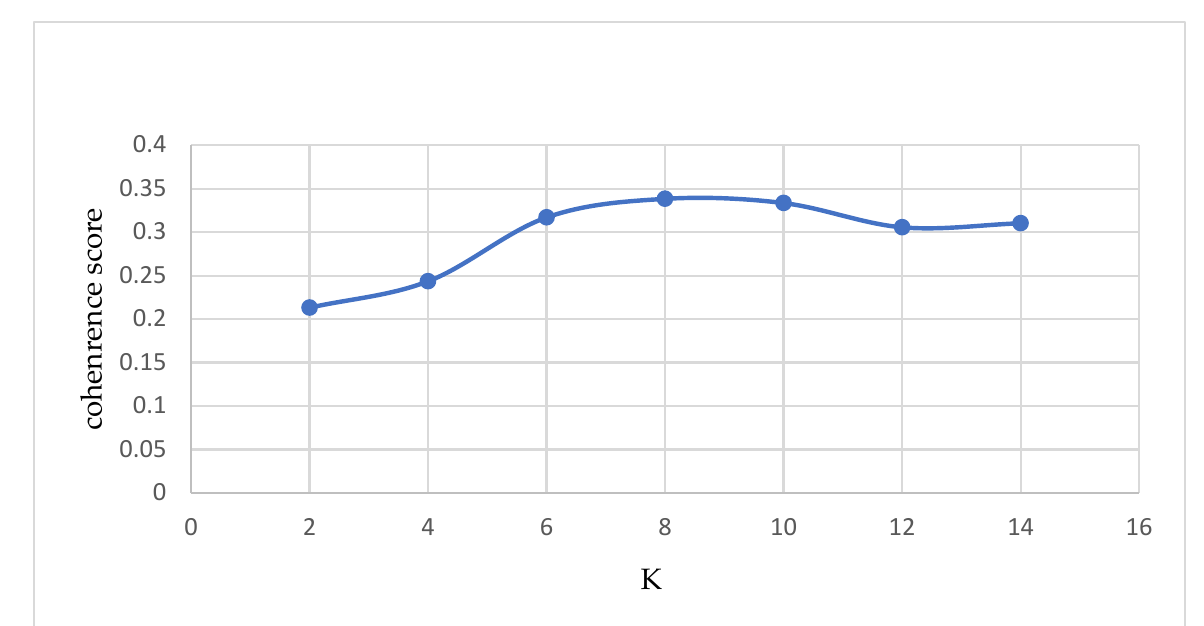
Figure 3. K value coherence score line chart.